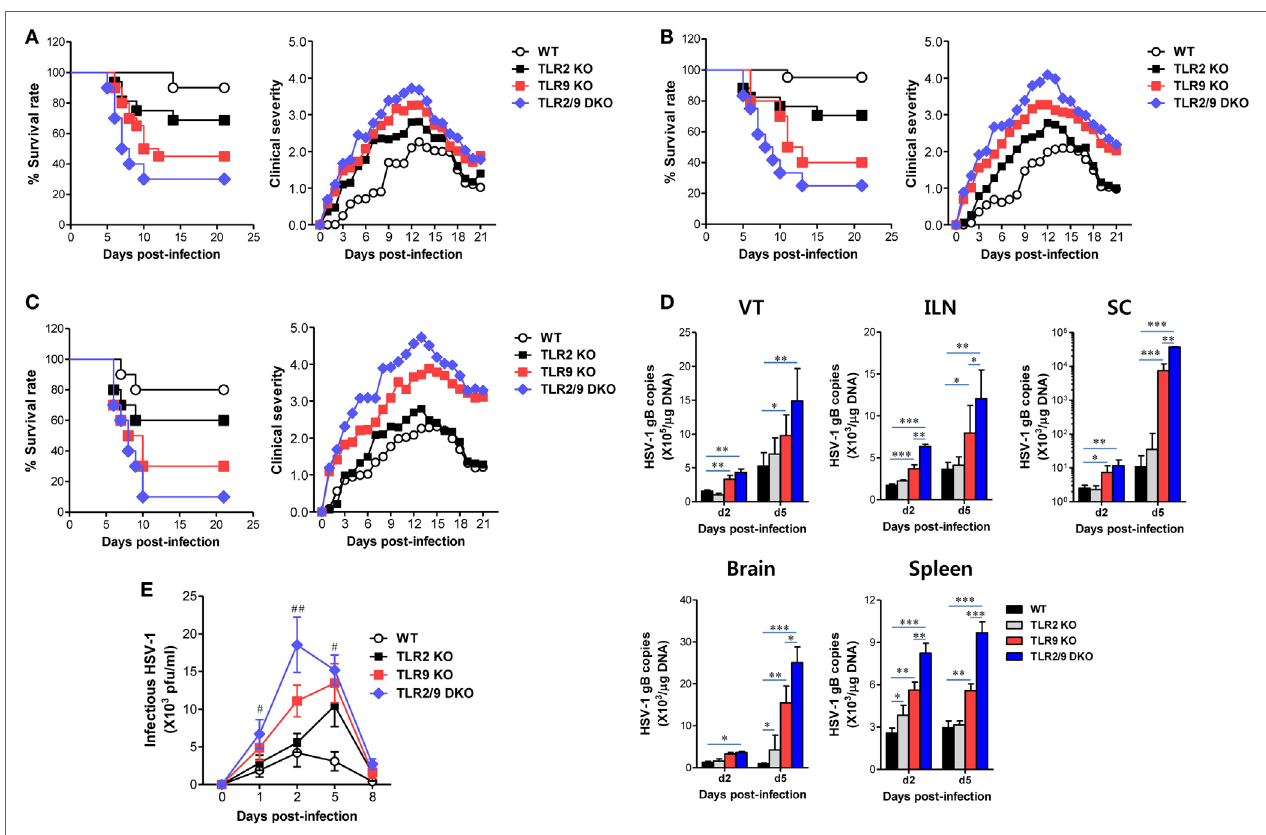
FigUre 1 | Susceptibility and viral burden of TLR2 KO, TLR9 KO, and TLR2/9 double knock-out (TLR2/9 DKO) mice against mucosal herpes simplex virus (HSV)-1 infection. (a–c) Survival rate and clinical score. Wild-type (WT) (C57BL/6), TLR2 KO, TLR9 KO, and TLR2/9 DKO mice ( n = 9–12) were challenged intravaginal with different doses of the HSV-1 McKrae strain [ (a) : 1 × 10 6 , (B) : 1 × 10 7 , and (c) : 5 × 10 7 pfu/mouse]. Surviving mice were examined daily up to 21 days post-infection (dpi), and the clinical score was recorded at the indicated dpi. (D) Viral burden in inflammatory and lymphoid tissues. Viral burden in the vaginal tract (VT), iliac LNs (ILNs), spinal cord (SC), brain, and spleen of WT, TLR2 KO, TLR9 KO, and TLR2/9 DKO mice infected with HSV-1 (1 × 10 7 pfu/mouse) was assessed by real-time qPCR at the indicated dpi. The viral burden was expressed by viral DNA copy number per microgram of genomic DNA. (e) Infectious virus shedding in primary target tissues. Infectious virus titer was measured by a plaque-forming assay using vaginal lavages collected at the indicated dpi. Data represent the average ± SEM of the levels derived from at least three independent experiments ( n = 3–4). Two-way ANOVA followed by Bonferroni post hoc testing was conducted in (D,e) . * p < 0.05; ** p < 0.01; *** p < 0.001 comparing levels between the indicated groups; # p < 0.05; ## p < 0.01 comparing levels between TLR9 KO and TLR2/9 DKO